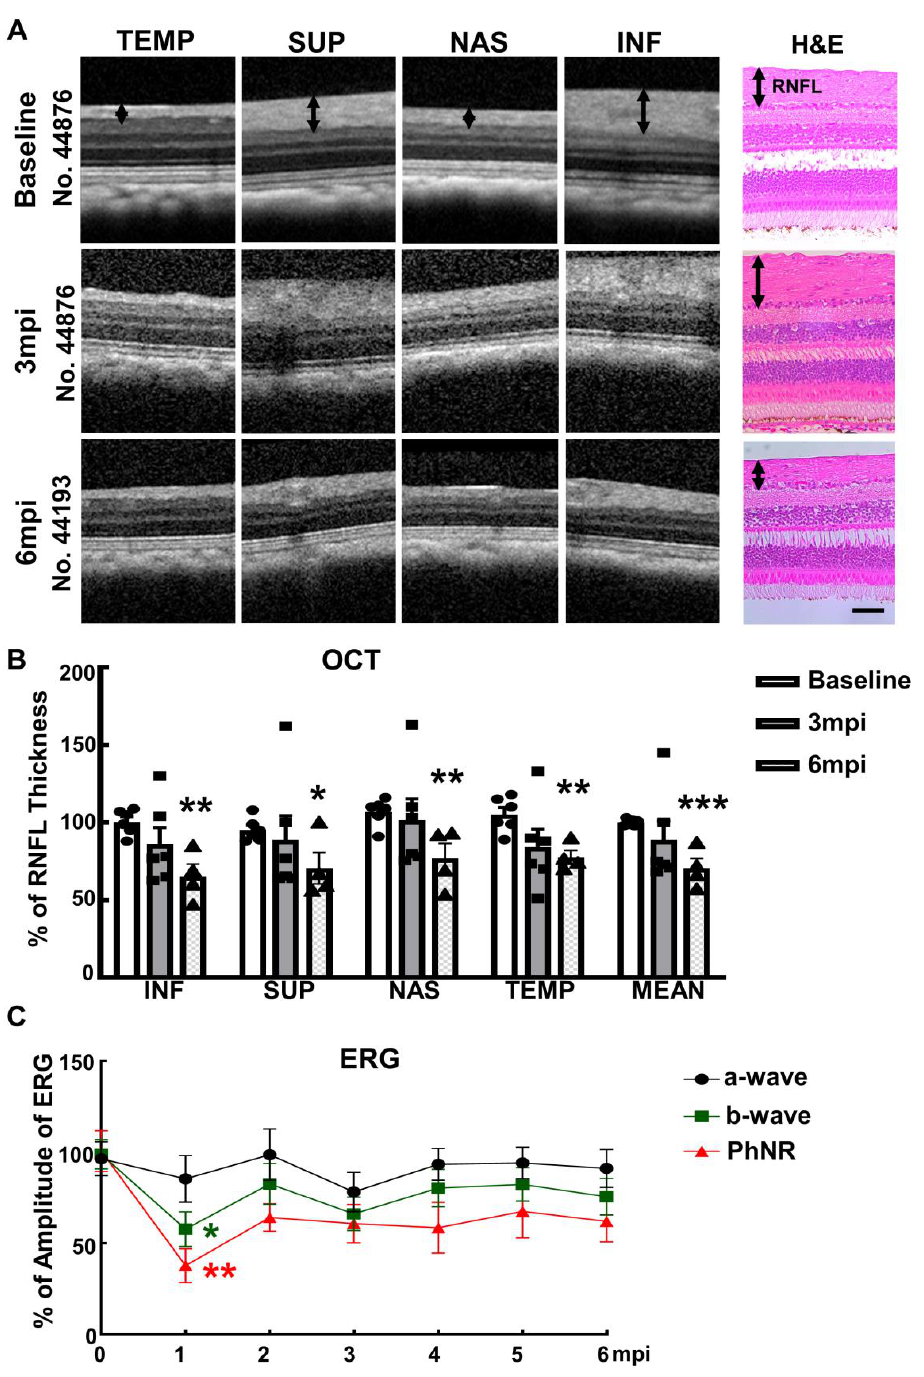
Figure 2. Visual function and morphological deficits of SOHU monkey eyes. ( A ) Longitudinal SD-OCT imaging of SOHU retinas at inferior (INF), superior (SUP), nasal (NAS), and temple (TEMP) quadrants; and the H & E staining of retina sections; ( B ) Measurements of RNFL thickness at different time points, represented as percentage of SOHU eyes compared to CL eyes. Data are presented as means ± s.e.m, n = 6 for 3 mpi and n = 4 for 6 mpi, *: p < 0.05, **: p < 0.01, ***: p < 0.001, Student’s t test; ( C ) Longitudinal ERG recording of macaque eyes at different time points after SO injection and the measurements of the amplitudes of a wave, b wave and PhNR, represented as percentage of the amplitudes in the SOHU eyes, compared to the CL eyes. Data are presented as means ± s.e.m, n = 6 for 1–3 mpi and n = 4 for 4–6 mpi, *: p < 0.05, **: p < 0.01, One-way ANOVA with Tukey’s multiple comparison